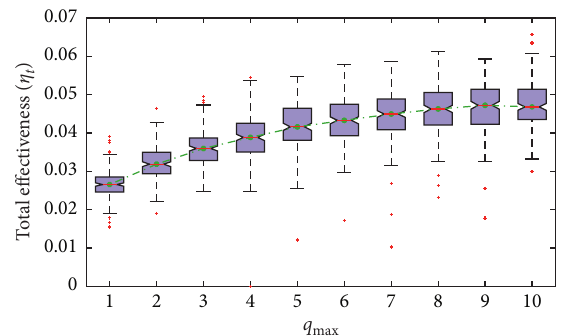
Figure 9: Investigating the effect of q significant increase in η t when we increase q